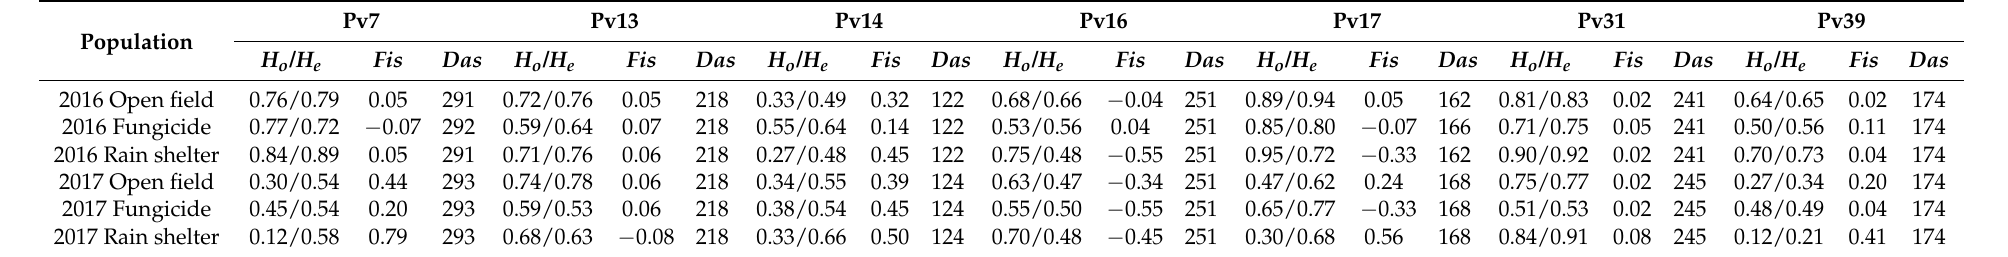
Table 6. The observed and expected heterozygosity ( H o and H e ), Fis and Das for each locus in Plasmopara viticola populations in open-field, fungicide-managed, and rain-shelter cultivations during the period